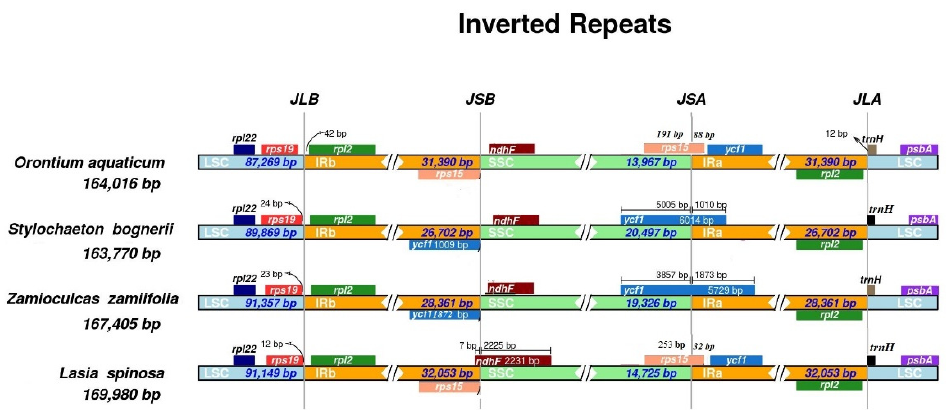
Figure 4. Comparison of quadripartite junction sites among chloroplast genomes of four assembled species. Genes present on top of track transcribe on the negative strand, whereas genes present below the track transcribe on the positive strand. The T scale bar shows integration of genes between two adjacent regions. The junctions of genomes are represented as follows: JLB: IRb/LSC, JSB: IRb/SSC, JSA: SSC/IRa, and JLA: IRa/LSC.